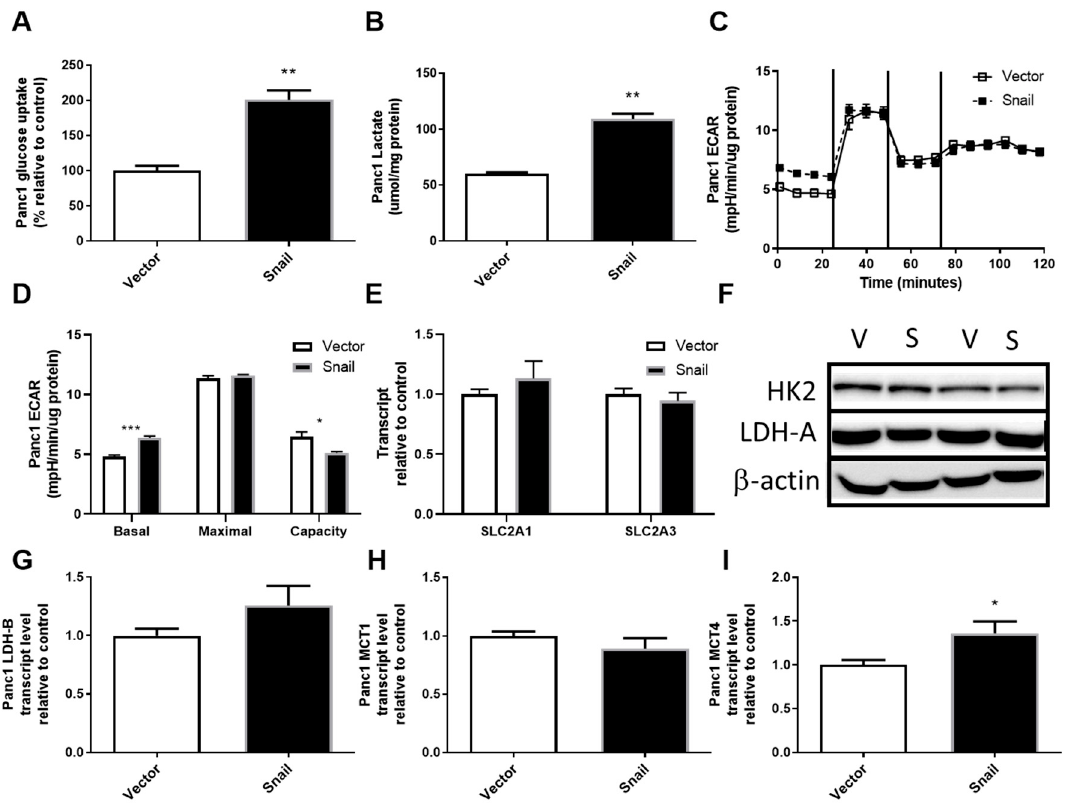
Figure 3. Effects of Snail overexpression on glucose uptake and lactate production in Panc1 cells. ( A ) Rate of glucose uptake measured using by 3 H-2-Deoxy-Glucose uptake over an 8 min period. ( B ) Lactate assay performed on cell culture media after 72 hours of culture. ( C ) Extracellular acidification rate (ECAR) measured using the Seahorse XF96 Analyzer at basal levels for 30 min followed by sequential injections of 1 µ M oligomycin, 0.5 µ M Carbonyl cyanide-4-(trifluoromethoxy)-phenylhydrazone (FCCP) and 1 µ M rotenone at 30 min intervals. ( D ) basal and maximal glycolytic activity and glycolytic capacity calculated from Seahorse data, ( E ) Fold-change in total RNA for SLC2A1 (encoding Glut1) and SLC2A3 (encoding Glut3) measured by qPCR using β -actin as housekeeper, ( F ) Immunoblotting results for hexokinase II (HK2) and lactate dehydrogenase A (LDH-A) with β -actin as loading control. ( G – I ) Fold change in total RNA detected for lactate dehydrogenase-B (LDH-B) and monocarboxylate transporter 1 (MCT1) and 4 (MCT4). Results are shown as mean ± SEM with n = 3. * p < 0.05, ** p < 0.01 for difference between vector control and Snail-overexpressing cells.